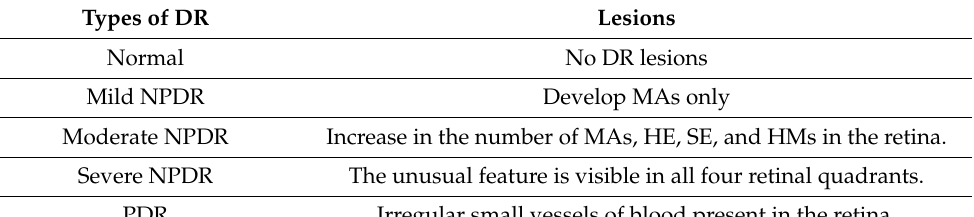
Table 1. Levels of DR.